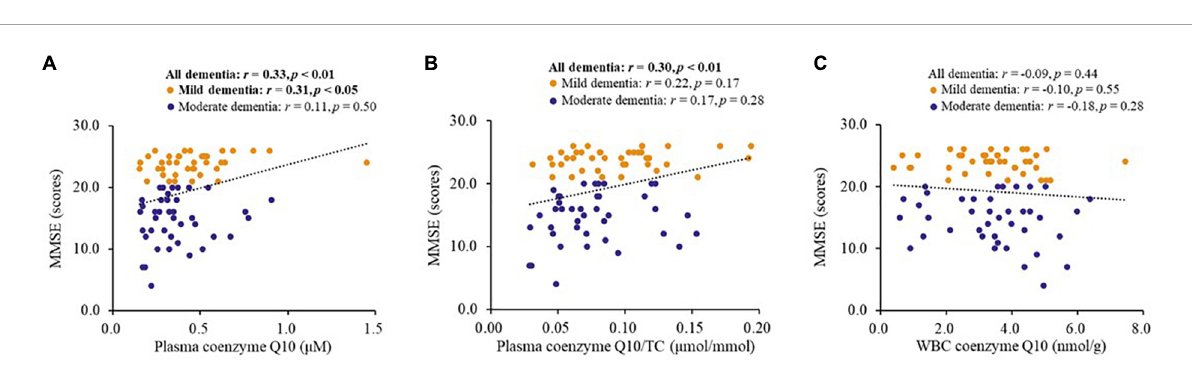
FIGURE4 Correlations between coenzyme Q10 status and the MMSE score of patients. CoQ10, A β , Tau in Dementia. (A) Correlation between the level of plasma coenzyme Q10 and MMSE score. (B) Correlation between the level of plasma coenzyme Q10/TC and MMSE score. (C) Correlation between the level of WBC coenzyme Q10 and MMSE